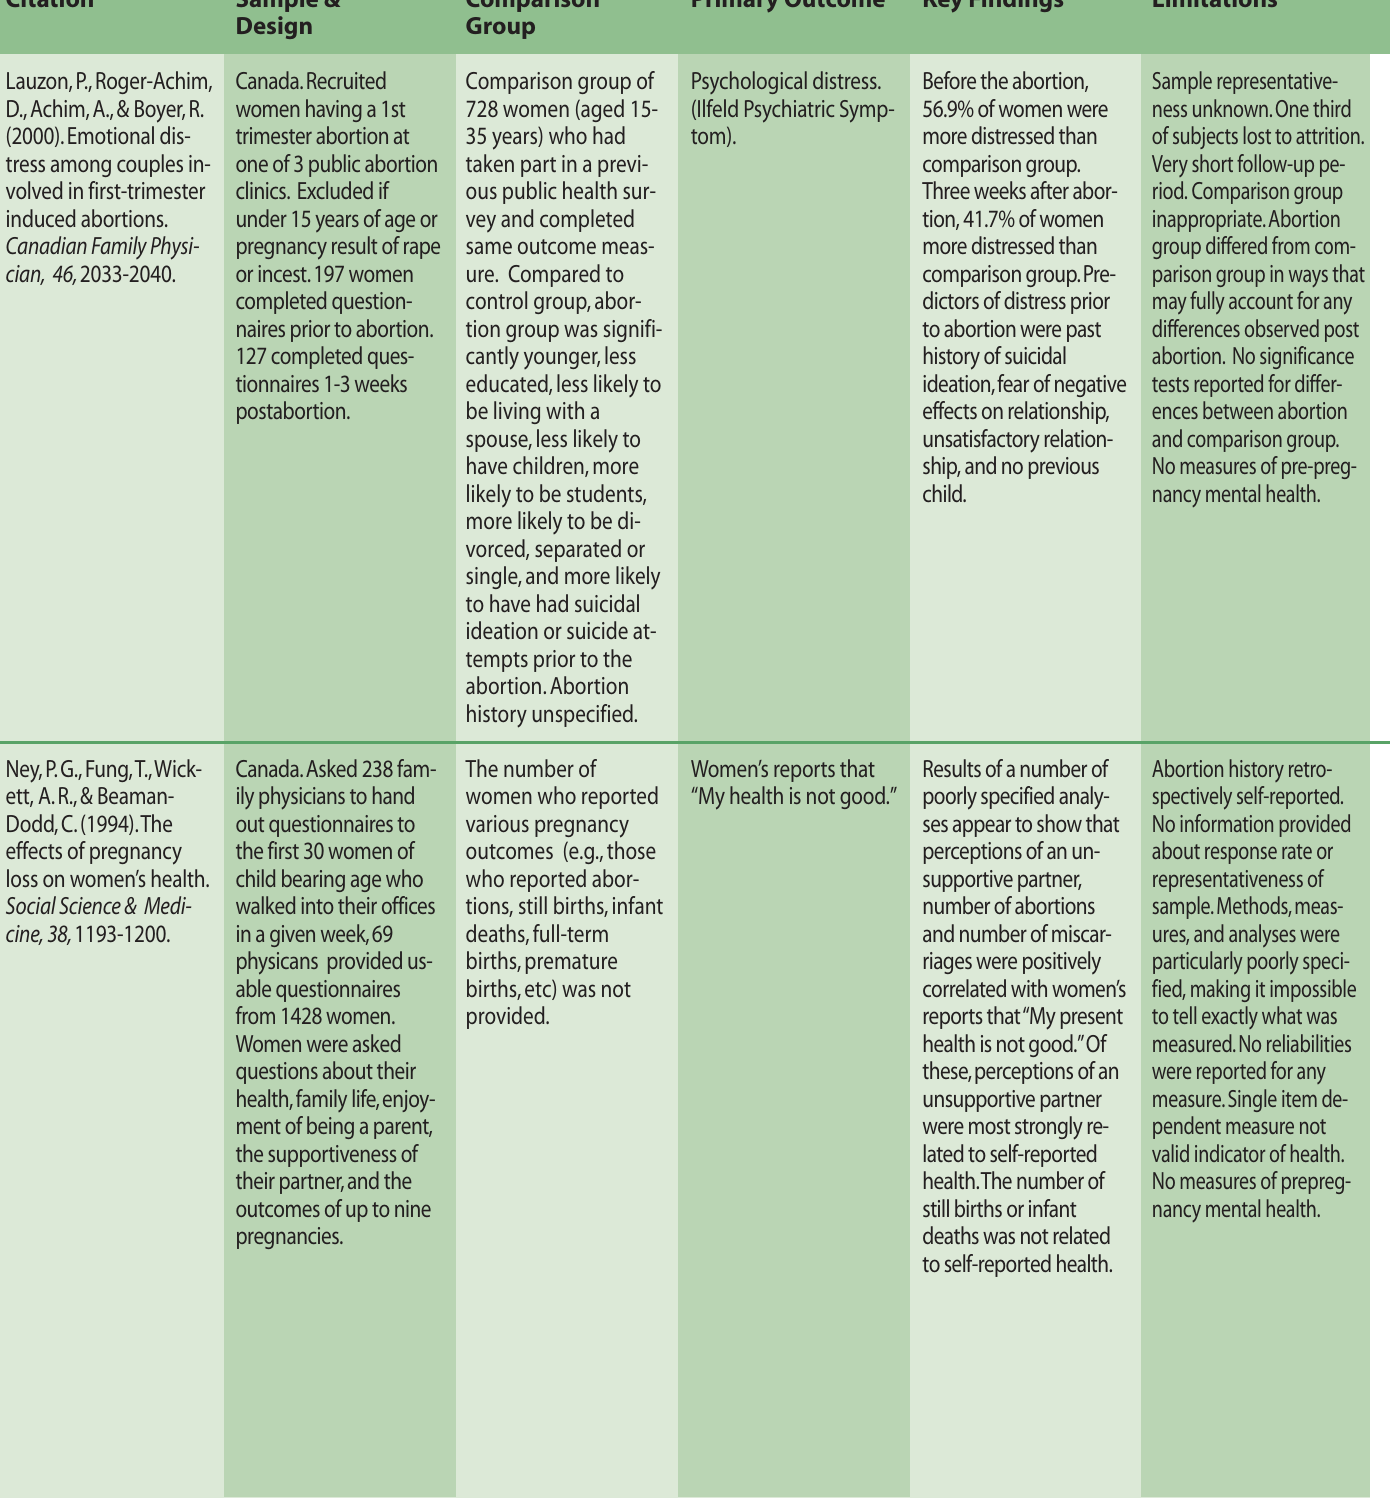
Table 3B: Primary Data Comparison Group Studies NON-U.S.SAMPLES